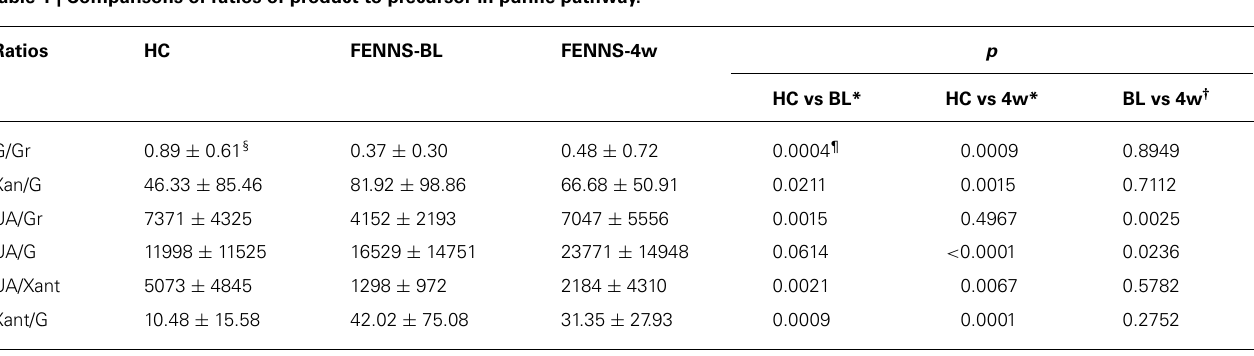
Table 1 | Comparisons of ratios of product to precursor in purine